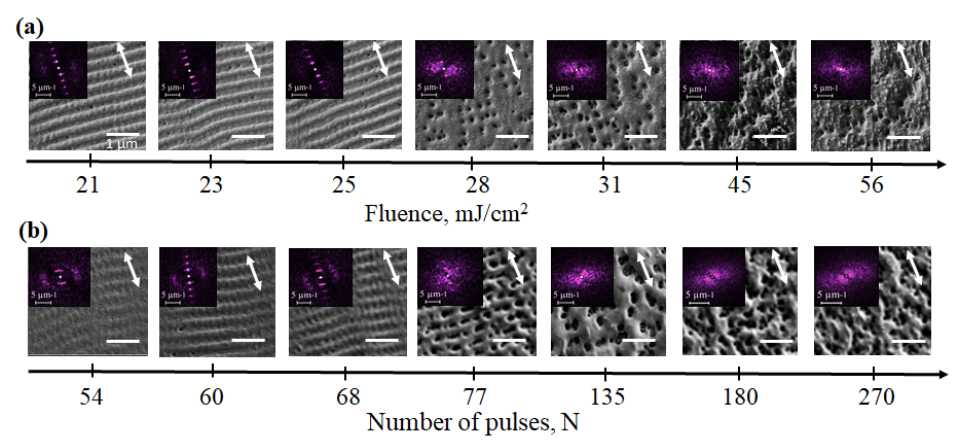
Figure 1. Evolution of periodical nanostructurs formation on TiO 2 :Ag film: ( a ) With the increase of power density for N = 540; ( b ) With the increase of N for F = 27 mJ/cm 2 . Double arrow is a direction of (cid:126) E . Gratings with (cid:126) g || (cid:126) E and (cid:126) G ⊥ (cid:126) E are identified for F = 21–25 mJ/cm 2 and N =